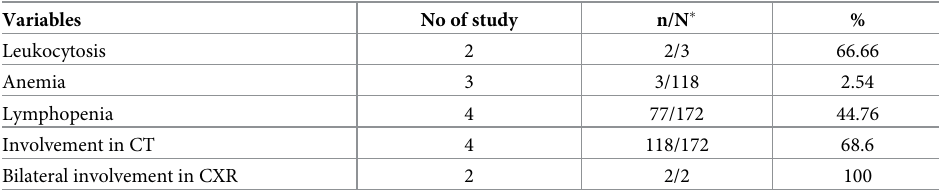
Table 3. Laboratory and imaging findings in the included studies.